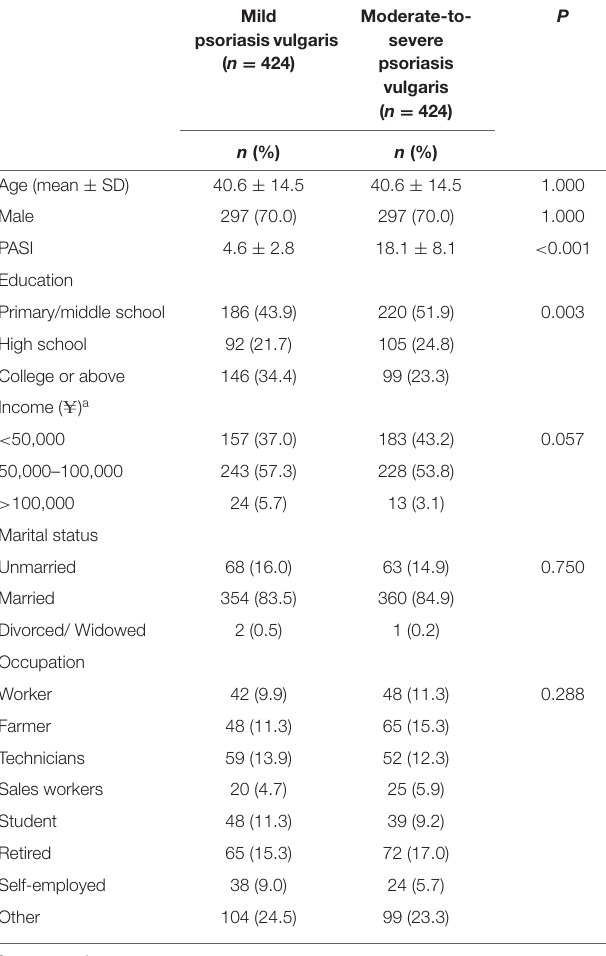
TABLE 4 | Subgroup analysis for the association between depression and anxiety the participants among two groups by PASI